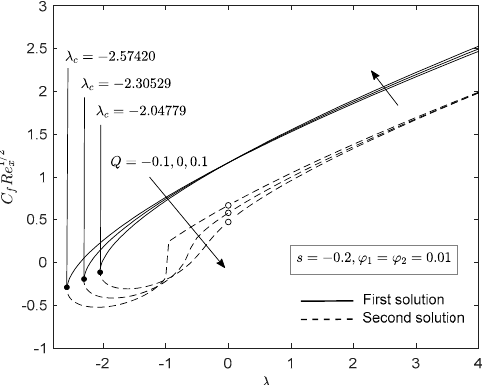
Figure 10. C f Re 1/2 x for different heat generation/absorption when s = 0.2.